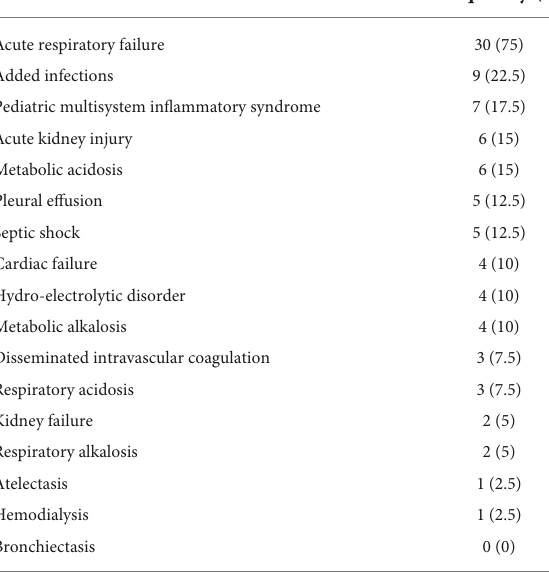
TABLE 3 Frequency of COVID-19 associated complications in cancer pediatric patients.